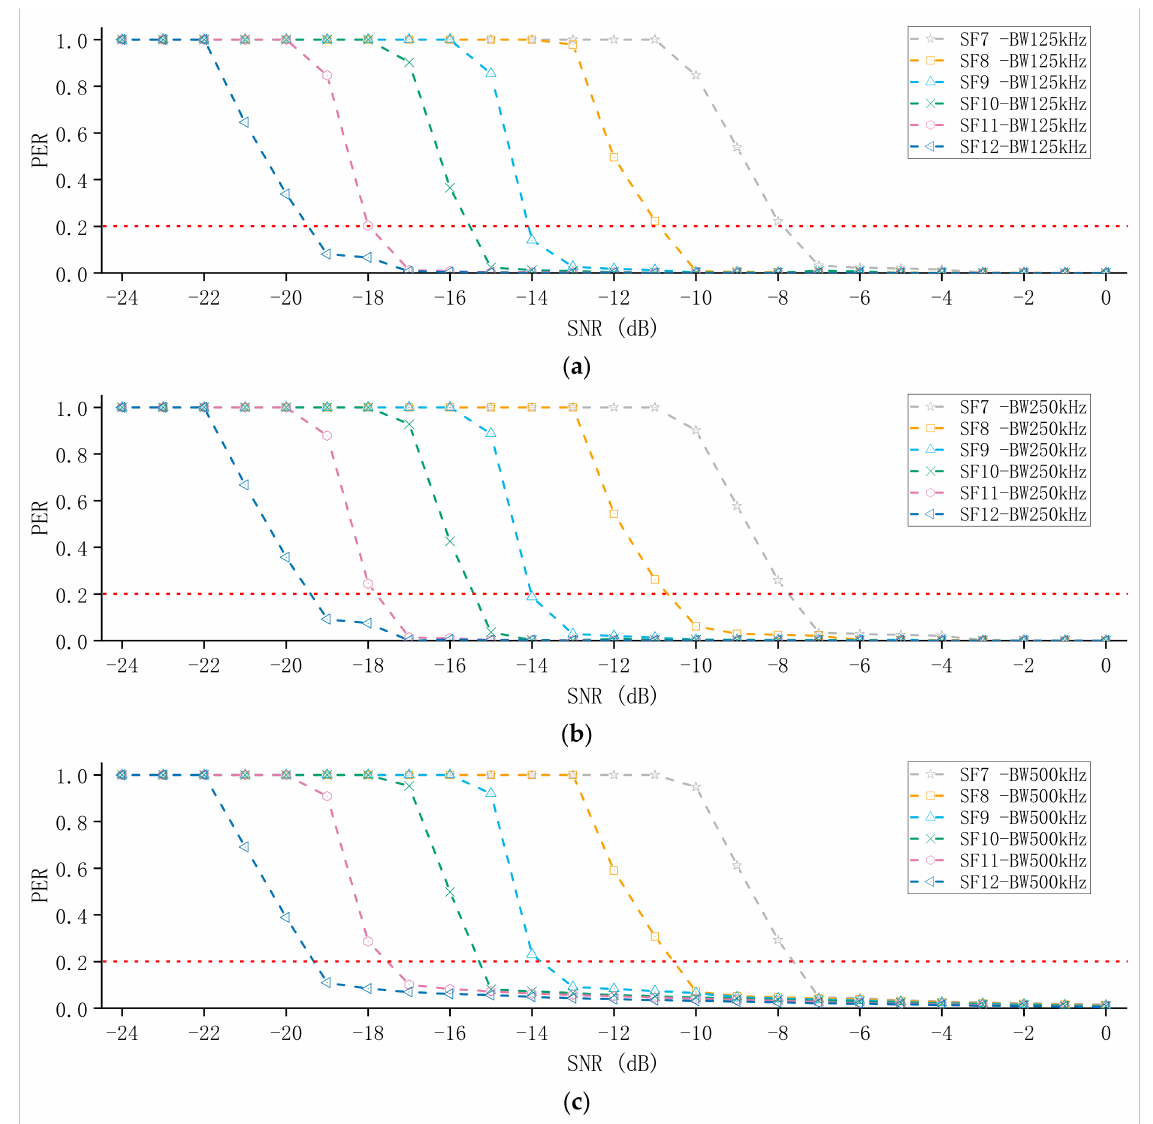
Figure 6. The measurement results of the impact of different SFs on the packet reception performance of LoRa: ( a ) BW = 125 kHz, measurement results of different SFs; ( b ) BW = 250 kHz, measurement results of different SFs; ( c ) BW = 500 kHz, measurement results of different